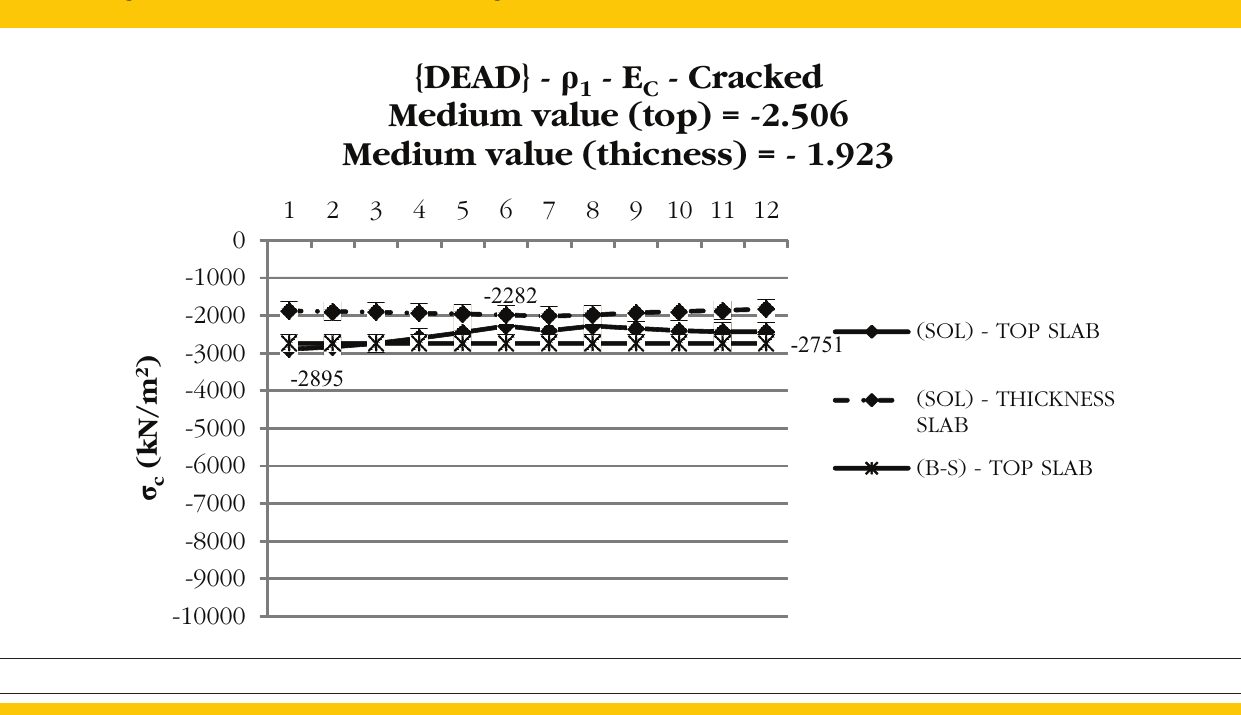
Figure 15 – Distribution of the longitudinal compression stress - {DEAD}, cracked section